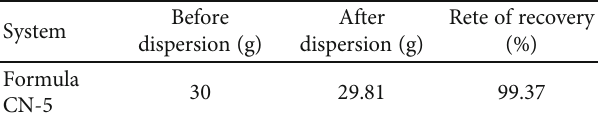
Figure 6: Experimental results linear swelling experiment. Table 11: Hot-rolling dispersion